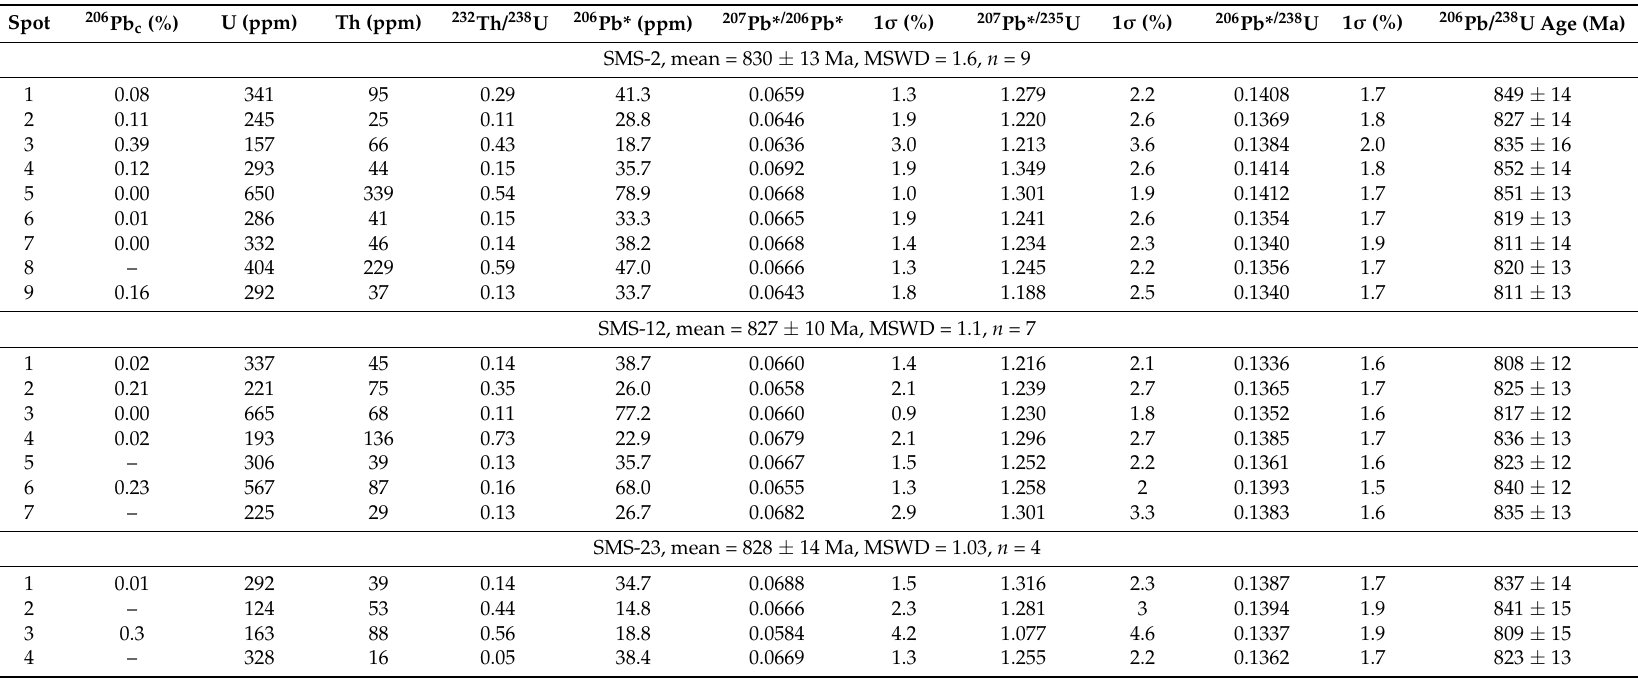
Table 3. SHRIMP zircon U–Pb data of the Shimensi